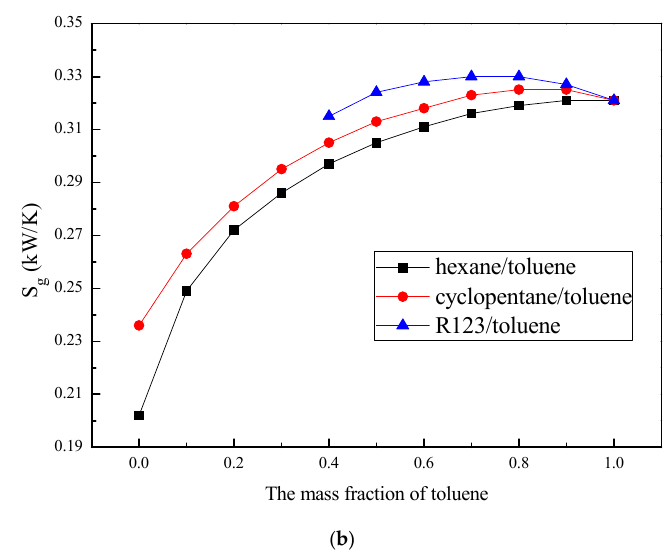
Figure 8. Effects of the working fluid mixture component: ( a ) Variation of the entransy loss rate; ( b ) variation of the entropy generation rate.